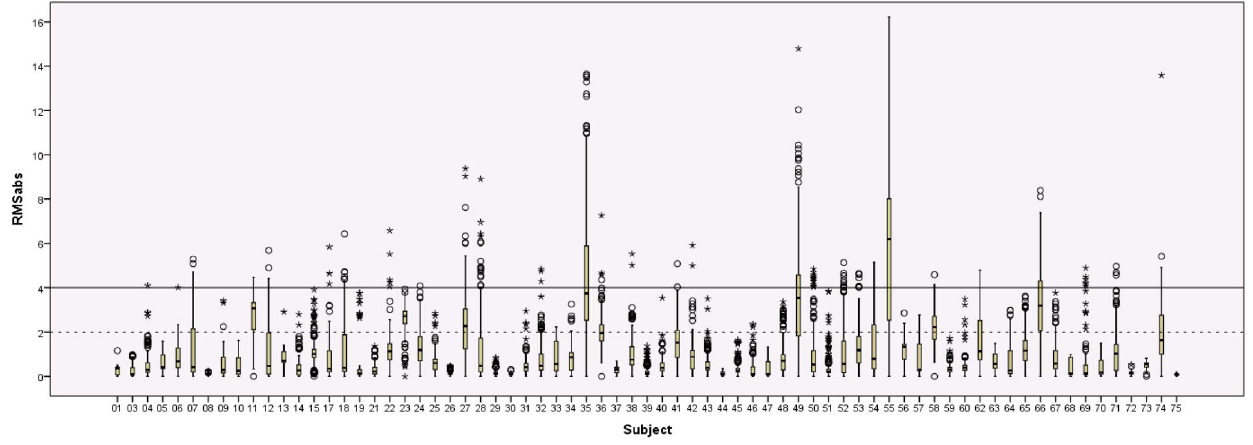
Figure 2. Boxplots of the RMS abs displacement over the time-series of the rfMRI scans. Boxplots of the absolute root mean squared motion are shown for each of the 71 children that underwent rfMRI scanning. Continuous line = width of one voxel, dotted line = half a voxel’s width.